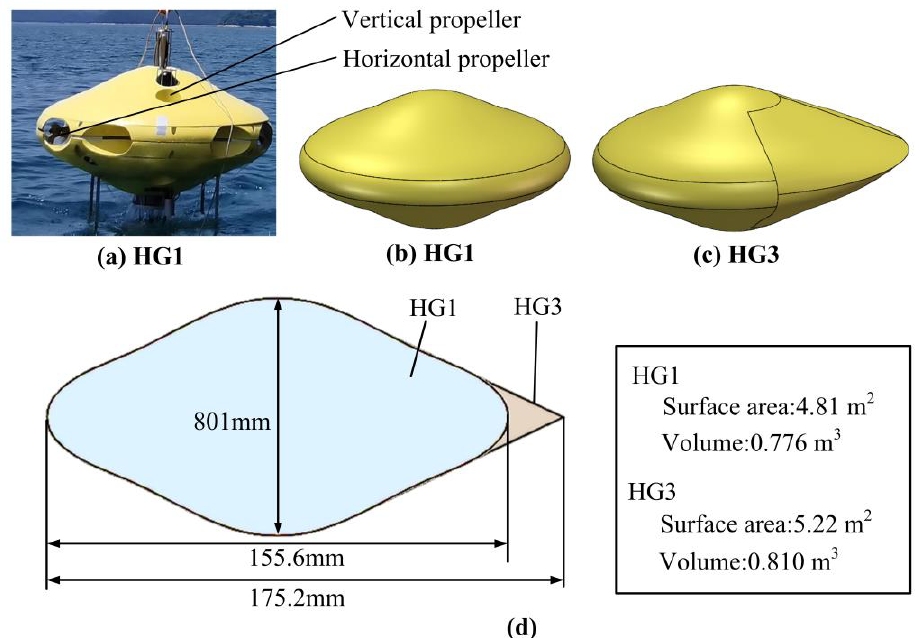
Figure 2. ( a ) AUH during a trial in the lake; ( b ) AUH with an original disk-shaped hull (HG1), ( c ) with an improved fore–aft asymmetric hull (HG3), and ( d ) profiles and geometric parameters of the HG1 and HG3. Table 1. Basic parameters of the current AUH (the HG1 geometry). Parameter Diameter ( 𝐦𝐦 ) Hight ( 𝐦𝐦 ) Weight ( 𝐤𝐠 ) Cruise Speed ( 𝐦/𝐬 ) Value 1557 801 ≤ 300 ≤ 2